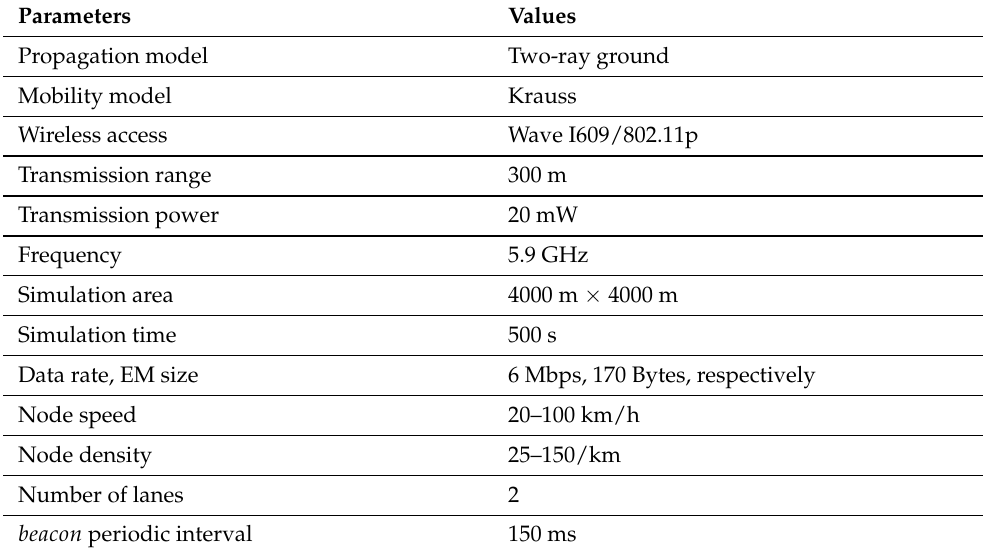
Table 4. Simulation